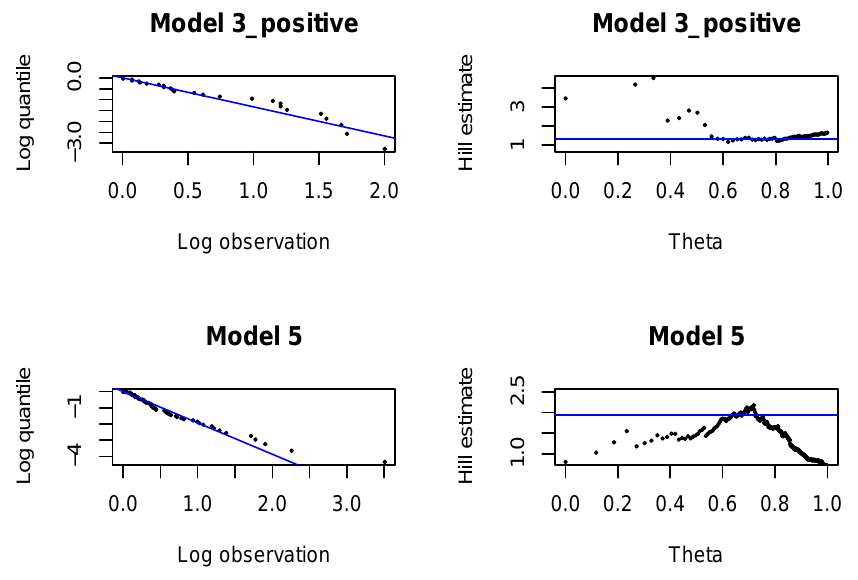
Figure A9. Pareto quantile plots and altHill plots for incremental payments and changes in claim incurred in k =